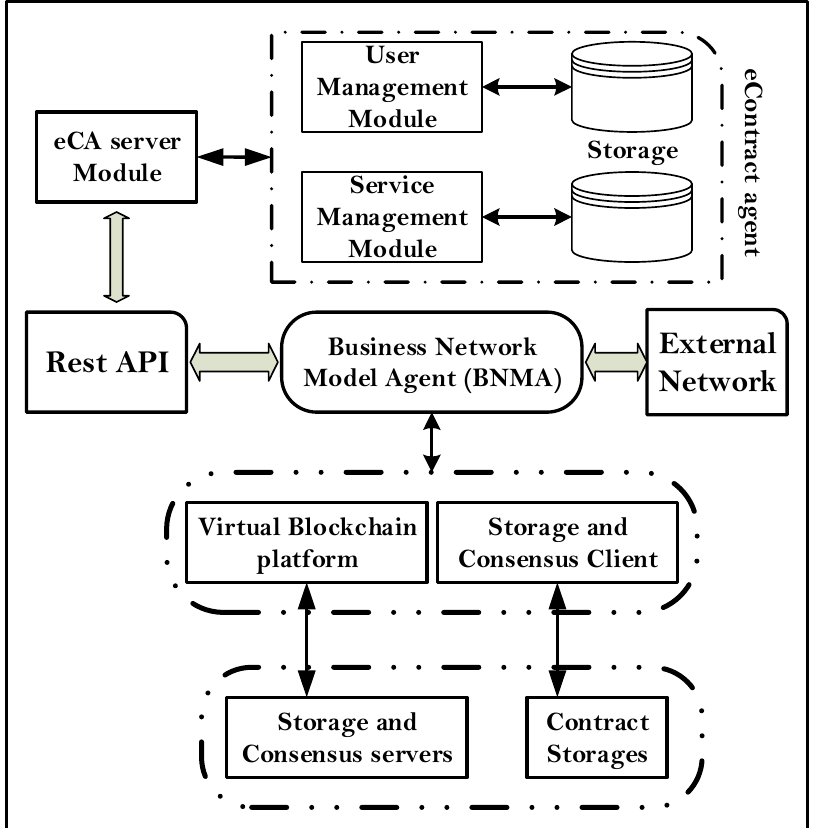
Figure 2. Typical structure of a smart contract system .